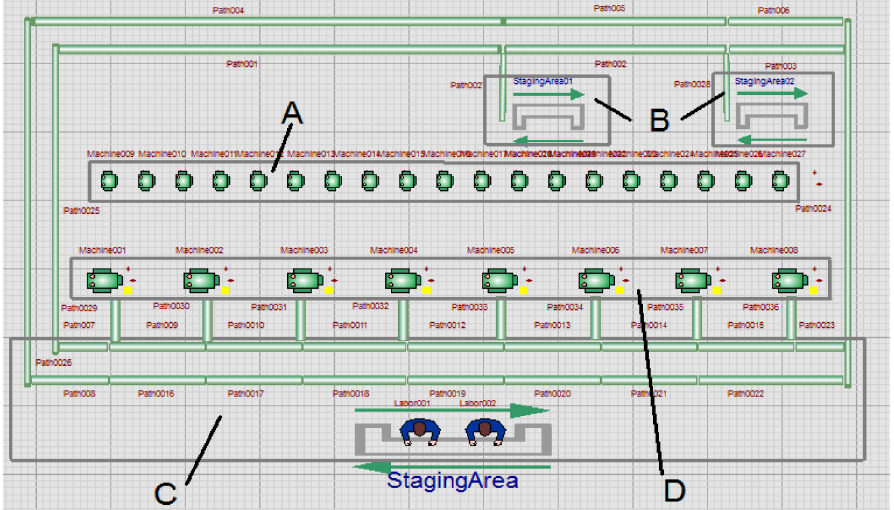
Figure 3. Simulation model interface of engine production line